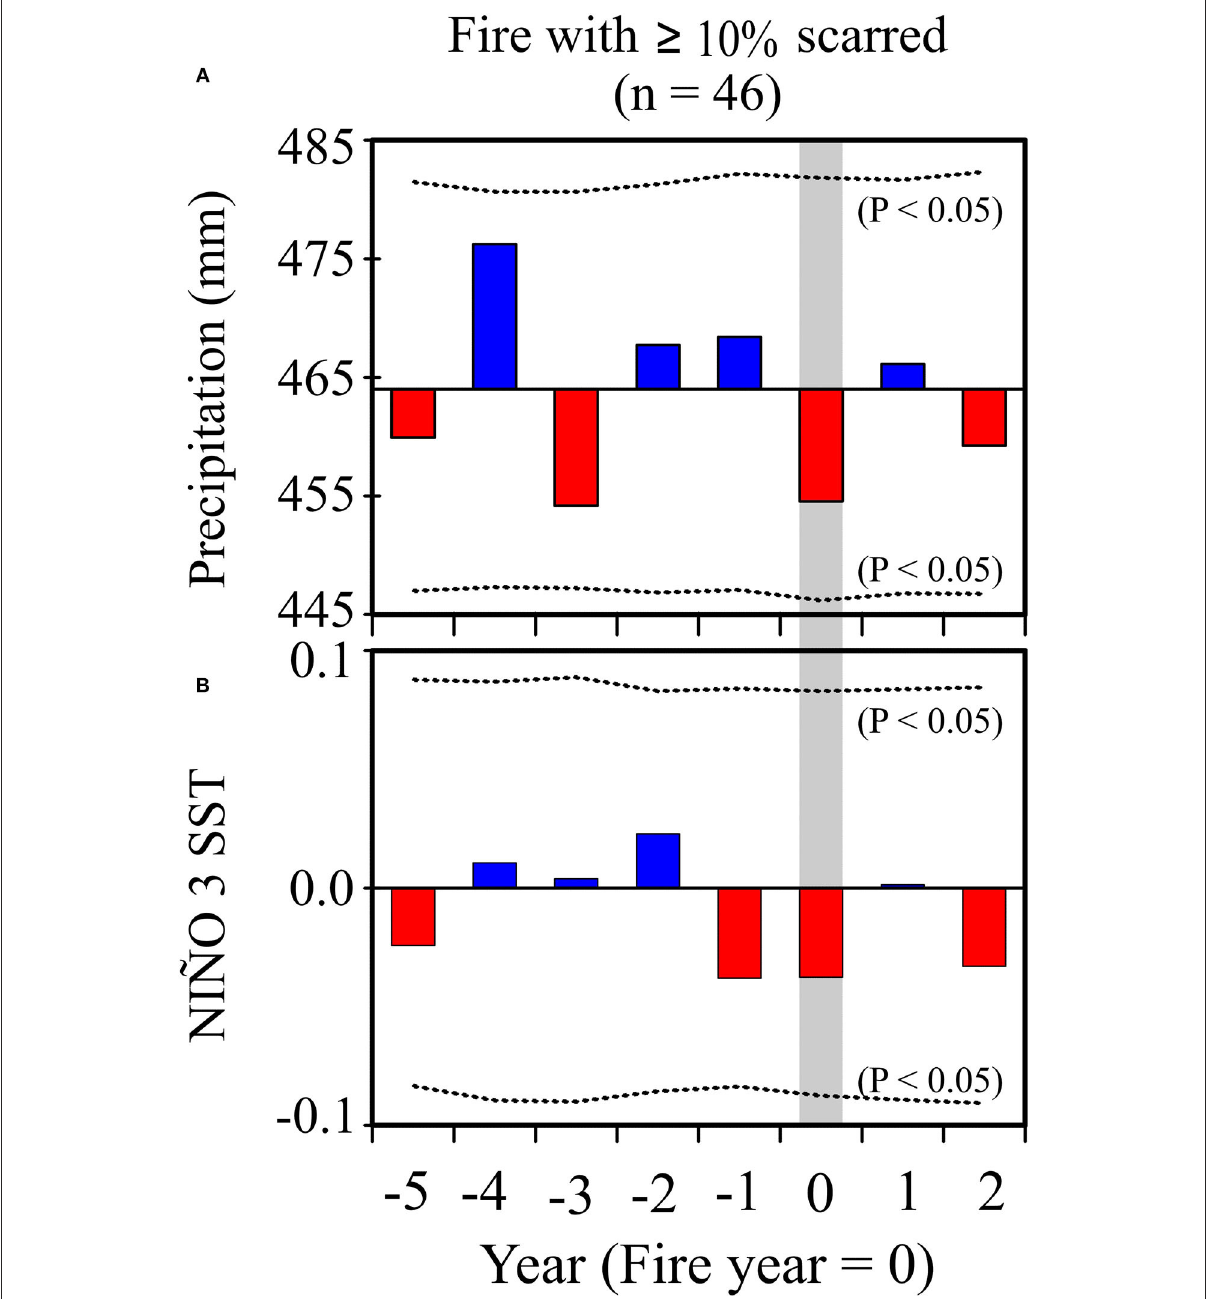
FIGURE5 Superposed Epoch analysis shows the relationship between fire occurrence and reconstructed local winter-spring precipitation variability (A) and NIÑO 3 SST indices (B), for all fires recorded by ≥ 10% of fire-scarred samples. The year of the fire is indicated by year 0, with bars corresponding to the average climate anomaly for fire years along with climate conditions 5 years prior to the fire (negative values) and 2 years after the fire (positive values). The upper and lower dotted lines represent the 95% confidence interval.